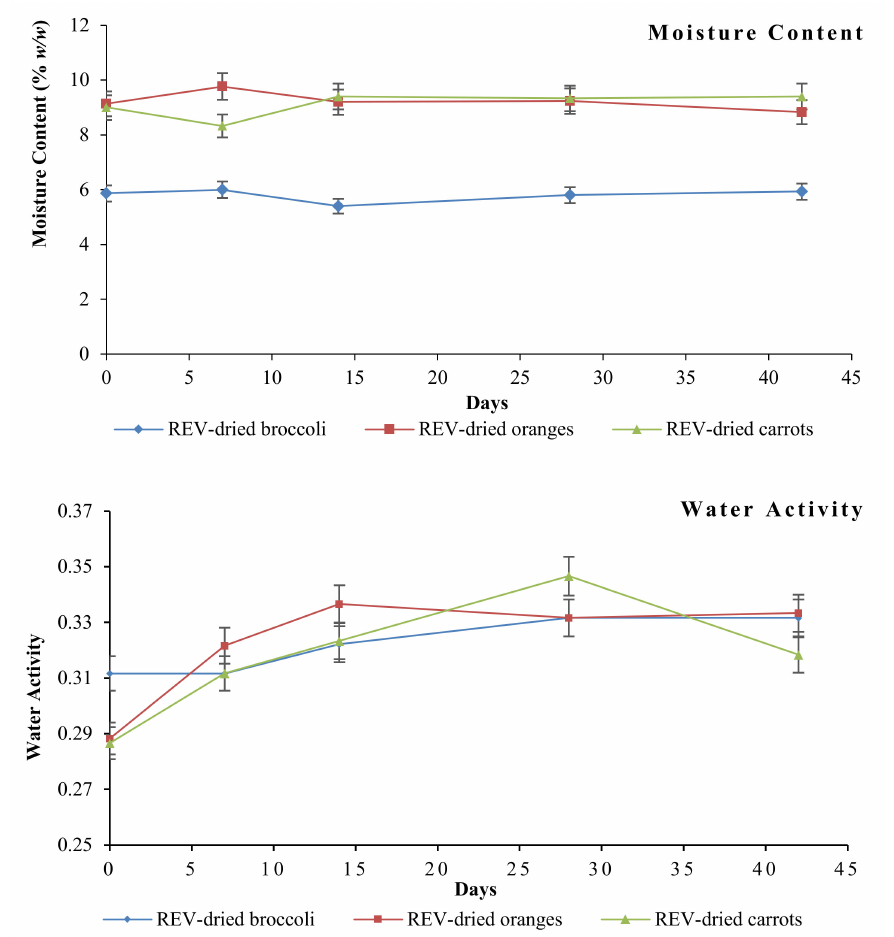
Figure 6. Changes of moisture content and water activity of REV-dried broccoli, orange, and carrot over the accelerated